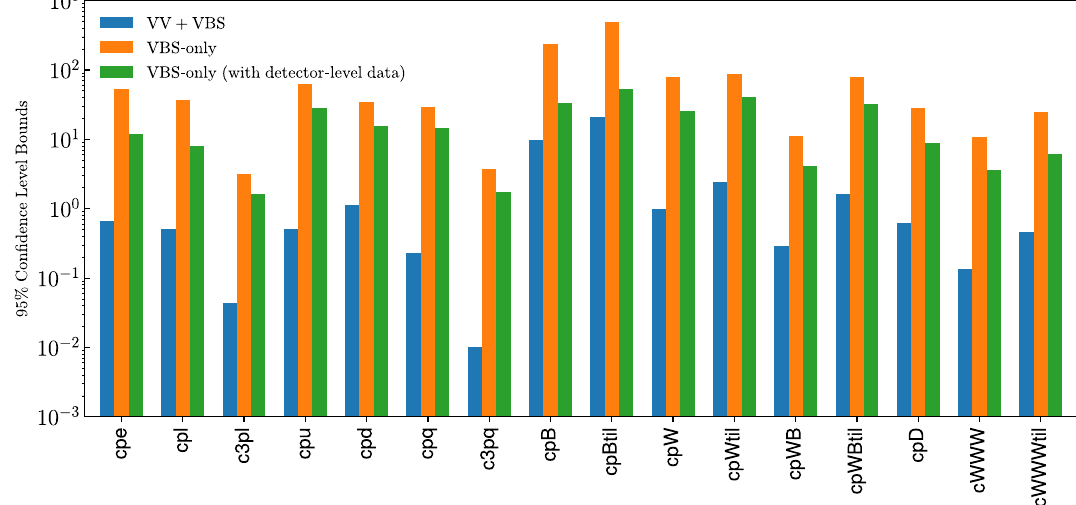
Fig. 26 Comparison of the results of the VBS-only fit based only on unfolded cross-sections with those of the same fit where in addition one includes the detector-level distributions. For reference, we also display the results for baseline VBS+diboson dataset